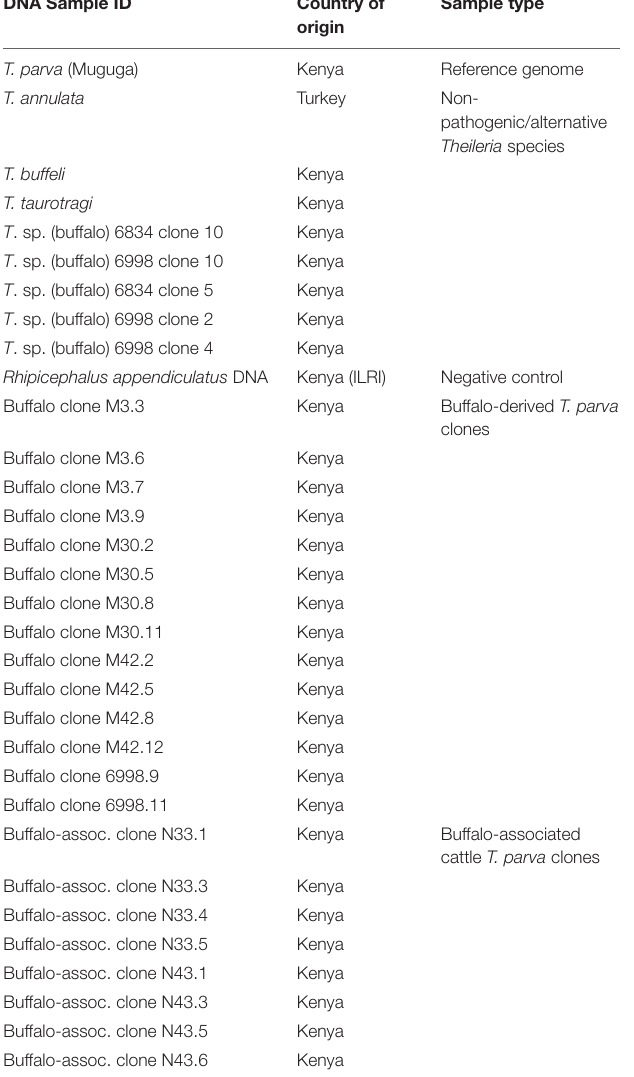
TABLE 1 | DNA panel used to test primer specificity. DNA Sample ID